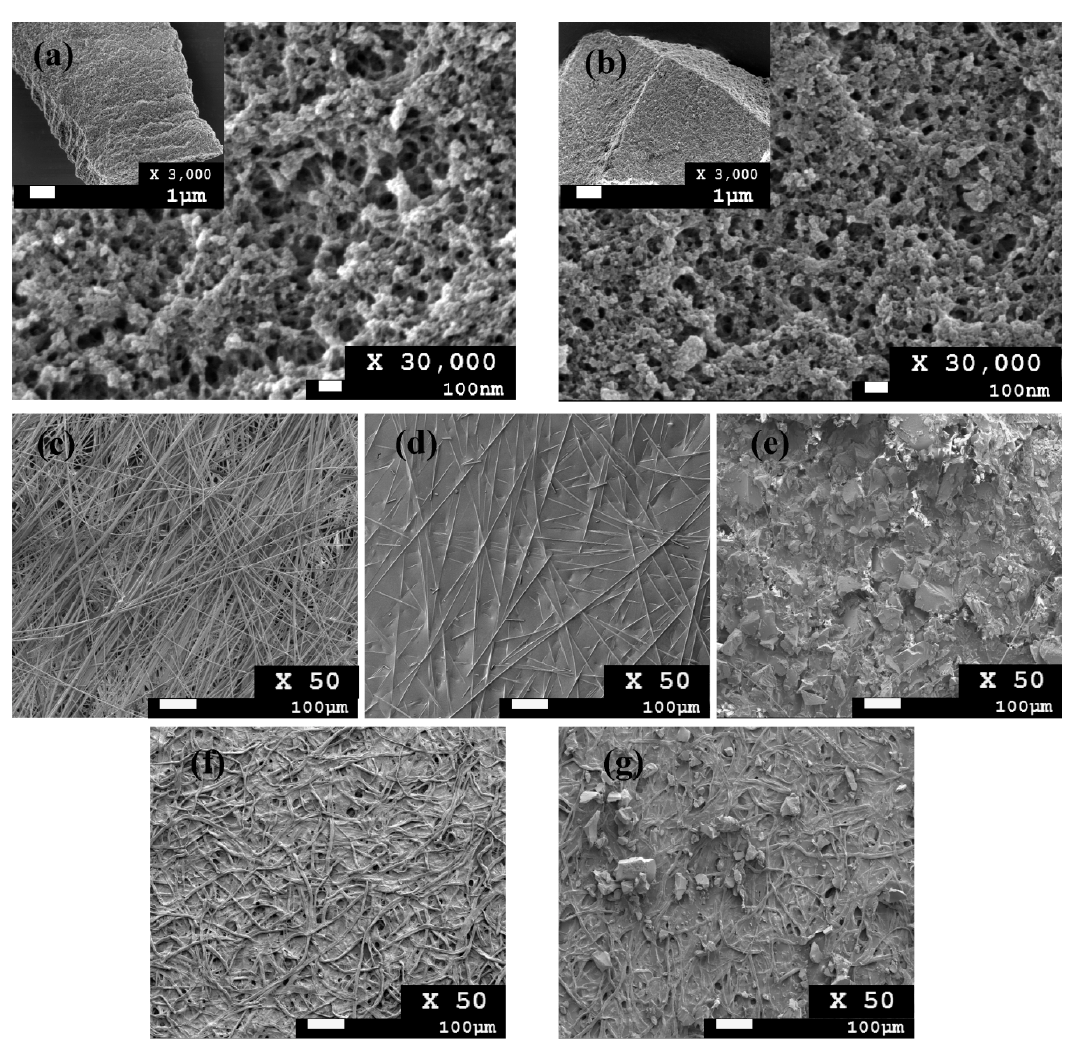
Figure 2. Structural morphology of ( a ) non-imprinted polymers (NIPs), ( b ) MIPs, ( c ) glass fiber membrane, ( d ) glass fiber membrane with 0.5% agarose gel, ( e ) MIP paper scaffold, ( f ) filter paper (Whatman No. 1), and ( g ) MIPs immobilized on filter paper.